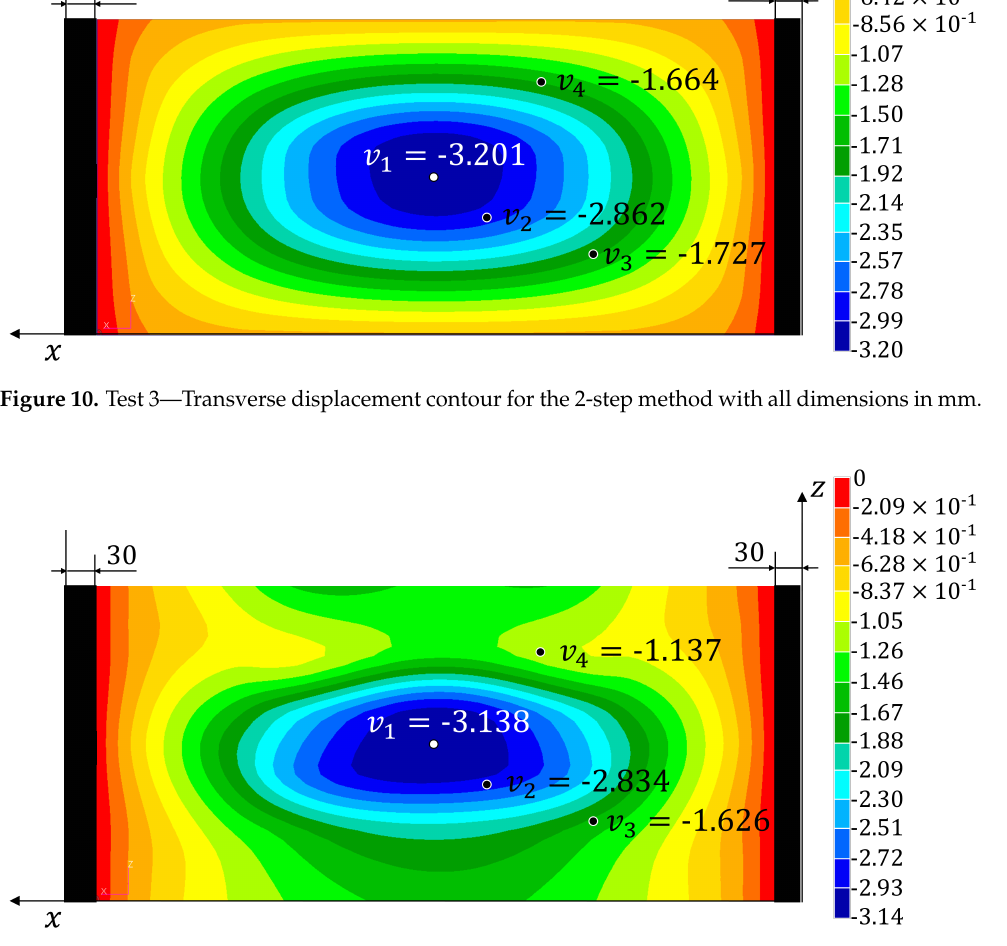
Figure 11. Test 3—Transverse displacement contour for the Model Method (1-22) with all dimensions in mm.